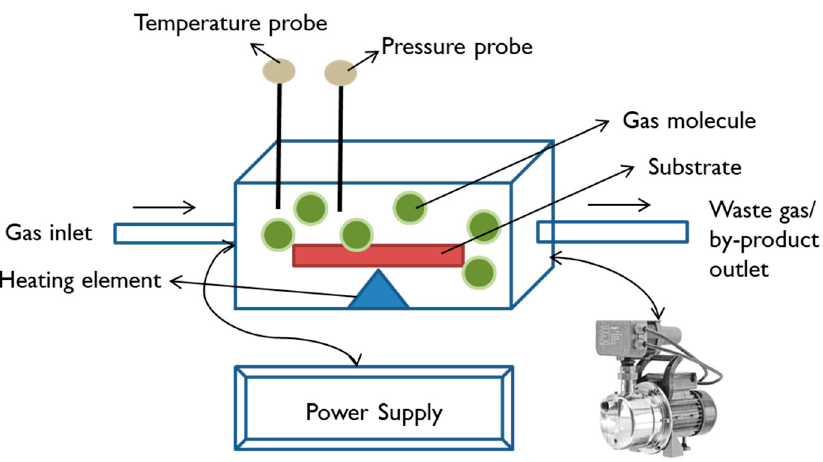
Figure 23. The illustration of coating a substrate via chemical vapour deposition. The components involved in the process include gas inlet, outlet for waste gas, probes for temperature and pressure measurement, heater to increase the substrate temperature, and power supply.